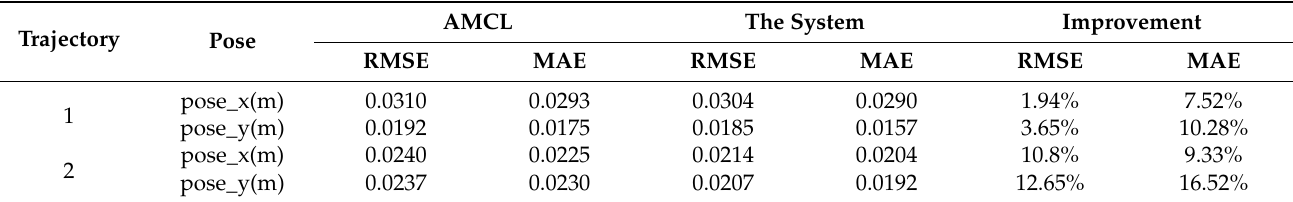
Table 5. The results of the pose estimation errors in the x and the y directions, respectively.